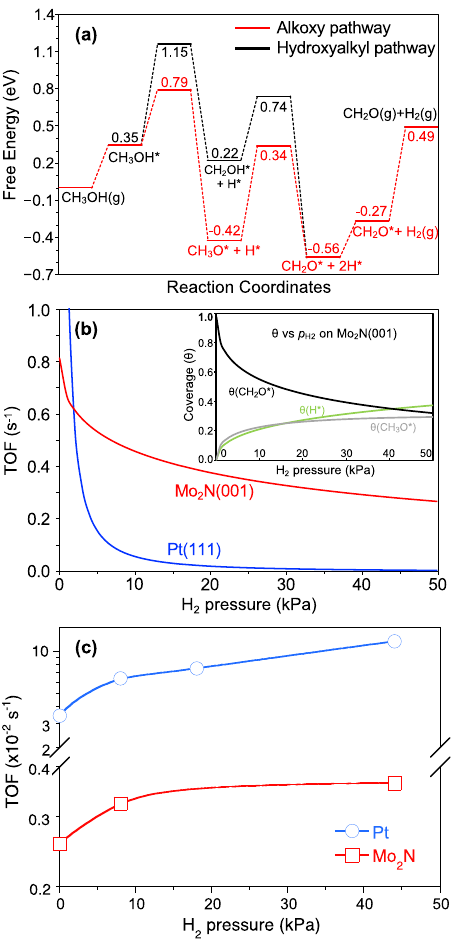
Fig. 3 Alcohol dehydrogenation over Mo 2 N. a Free energy diagram for CH 3 OH dehydrogenation at 453 K on β -Mo 2 N(001) surface; b Predicted TOF of CH 2 O from CH 3 OH dehydrogenation on Pt(111) and β -Mo 2 N(001) surfaces at variable cofeeding H 2 partial pressure ( p H2 ) at 453 K with p = 14 kPa as well as the coverage changes of important CH3OH intermediates on β -Mo 2 N (001) surface with p H2 ; c experimental evolution of the TOF for 2-octanol dehydrogenation as a function of the H 2 partial pressure for Pt and Mo 2